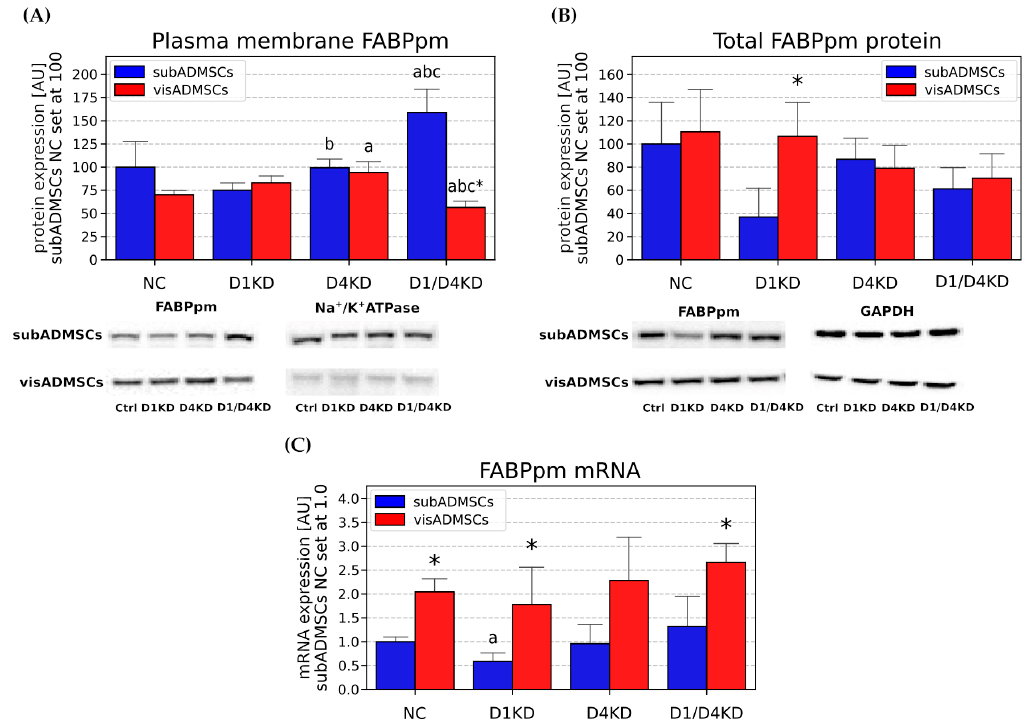
Figure 7. Plasma membrane ( A ), total protein ( B ) and mRNA ( C ) content of FABPpm in TBC1D1- and/or TBC1D4-deficient adipocytes. Bars and whiskers represent the mean and SD respectively. Number of patients equals four (measurements taken in duplicate). Values are expressed in arbitrary units; the mean in subADMSCs' negative control was set at 100. Representative Western blot images are shown. a—difference versus NC ( p < 0.05); b—difference versus D1KD ( p < 0.05); c—difference versus D4KD ( p < 0.05); * p < 0.05 significantly different from visADMSCs. Designation of the groups: NC – negative control containing non-targeting siRNA fragment; D1KD—knockdown of TBC1D1 ; D4KD—knockdown of